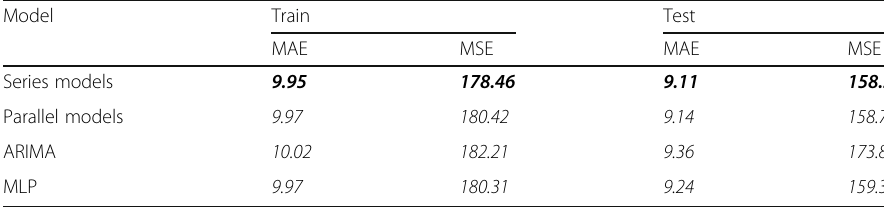
Table 5 Overall performance of series and parallel models for S&P 500